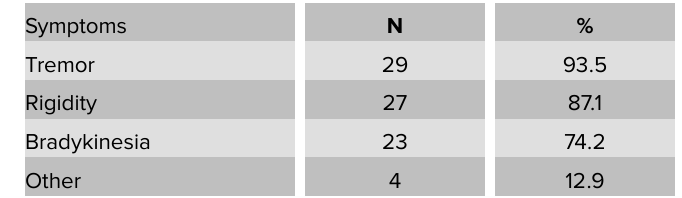
Table 1: The symptoms of PINK1 type early onset